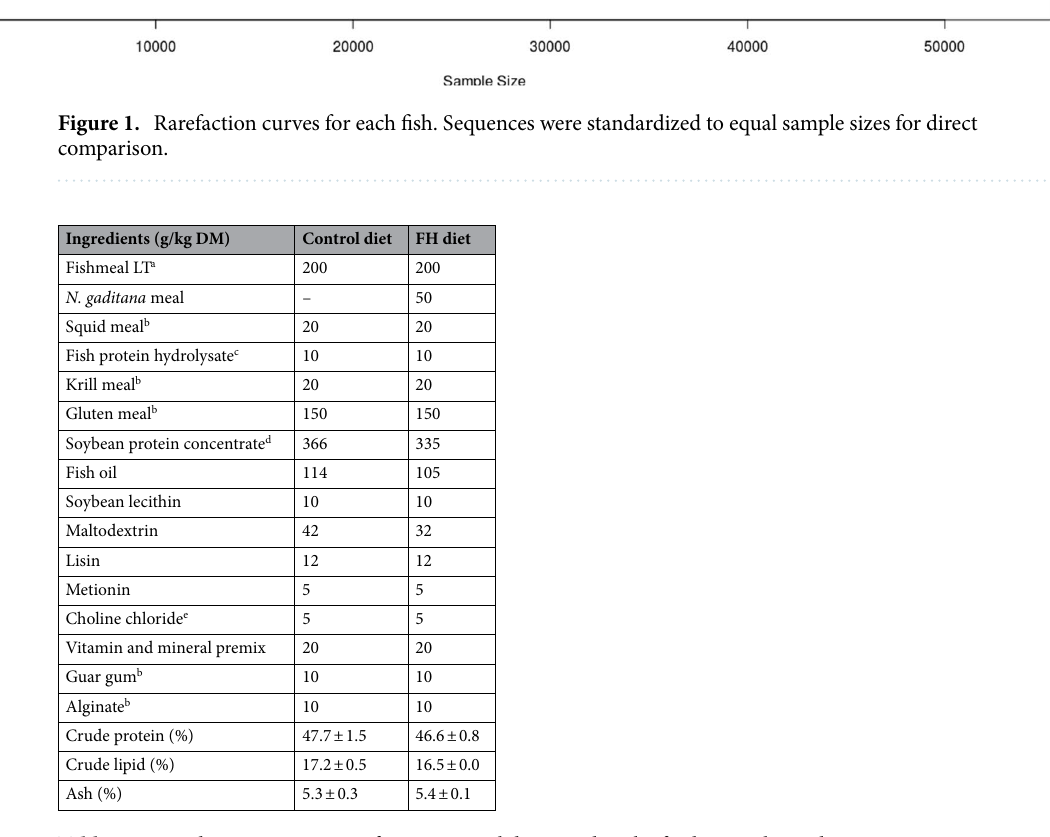
Table 1. Ingredient composition of experimental diets used in the feeding trial. FH diet contains 5% hydrolysed raw algal biomass. a Norsildemel (Bergen, Norway). b Lifebioencapsulation (Almería, Spain). c (81% crude protein, 8.8% crude lipid) Sopropeche (France). d (65% crude protein, 8% crude lipid) DSM (France). e Sigma-Aldrich (Madrid,